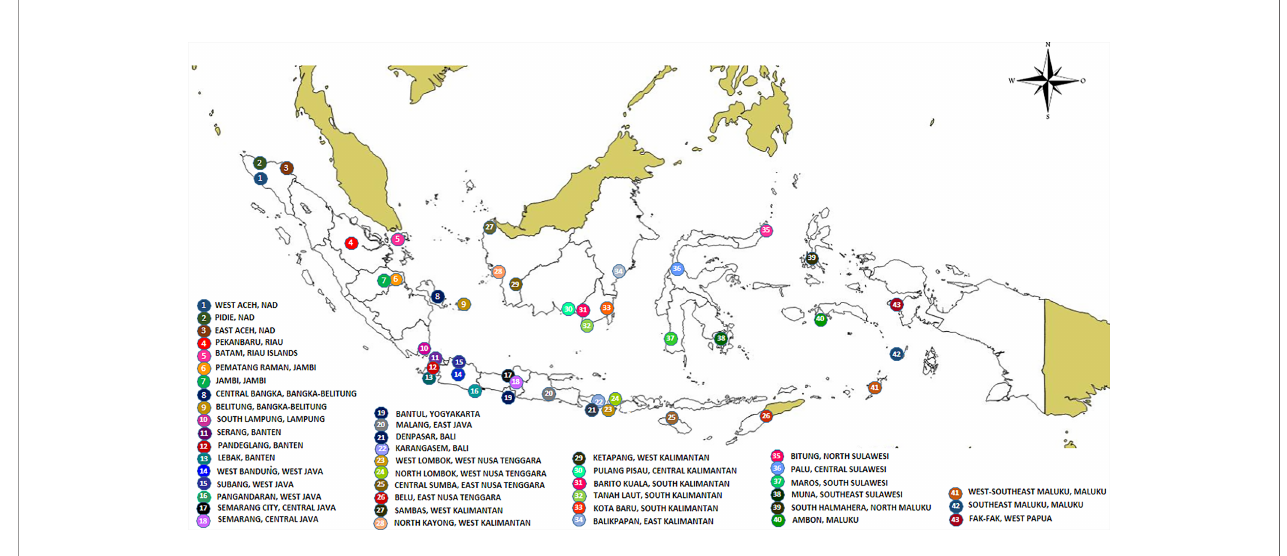
FIGURE 1 | Map of sampling